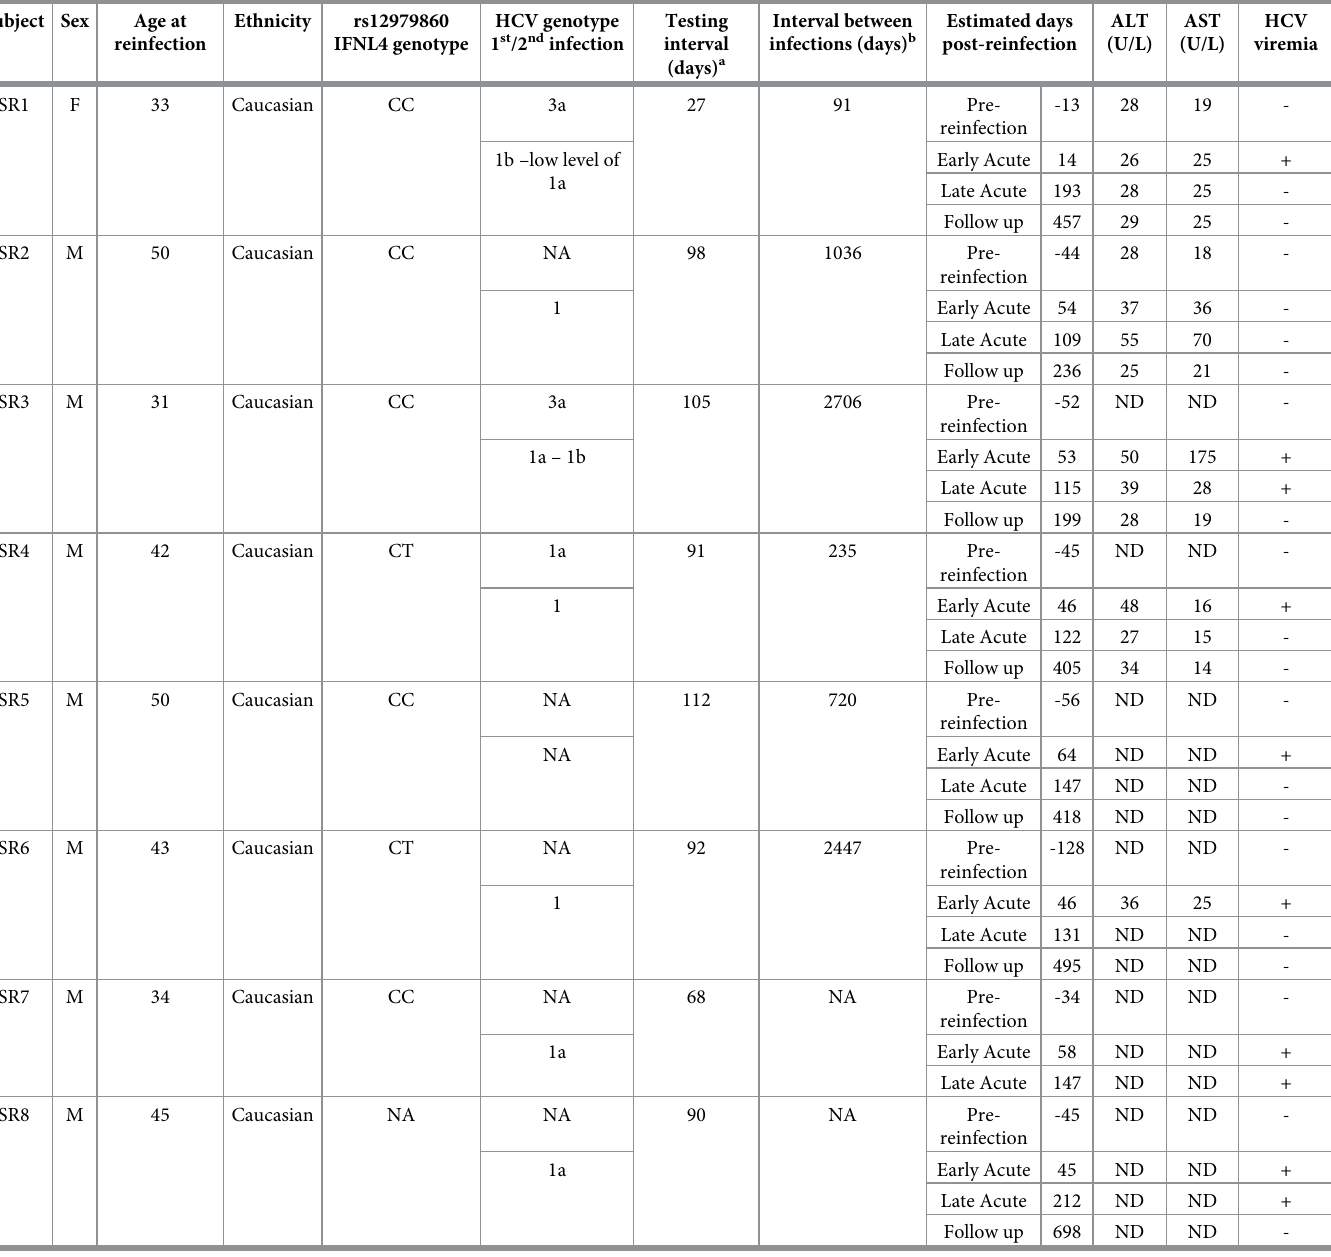
Table 1. Subjects’ Demographics and Clinical information for samples analyzed by